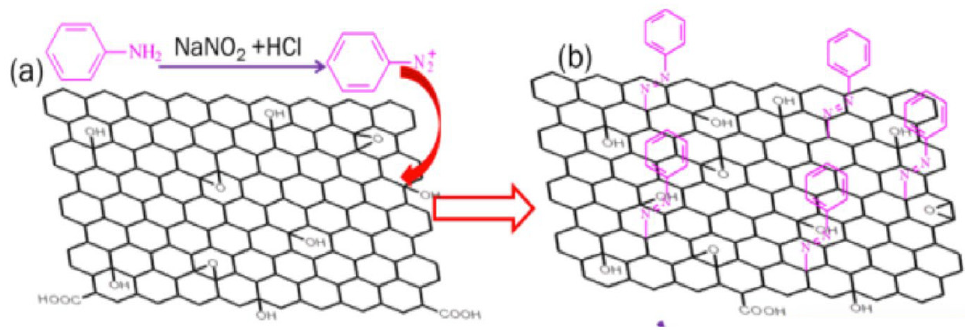
Figure 11. ( a ) The synthesis route, ( b ) chemical structures of trans AZO-GO hybrid